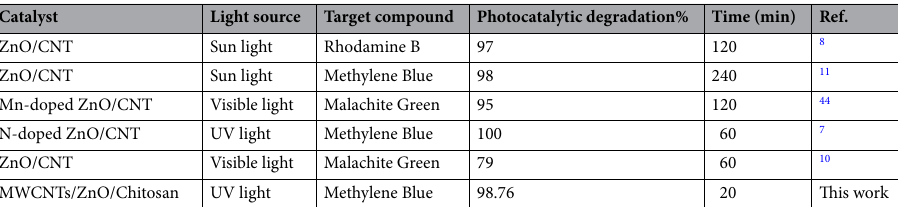
Table 3. Comparison of photocatalytic efficiency of CNT composites with other reported photocatalysts for organic dye degradation.